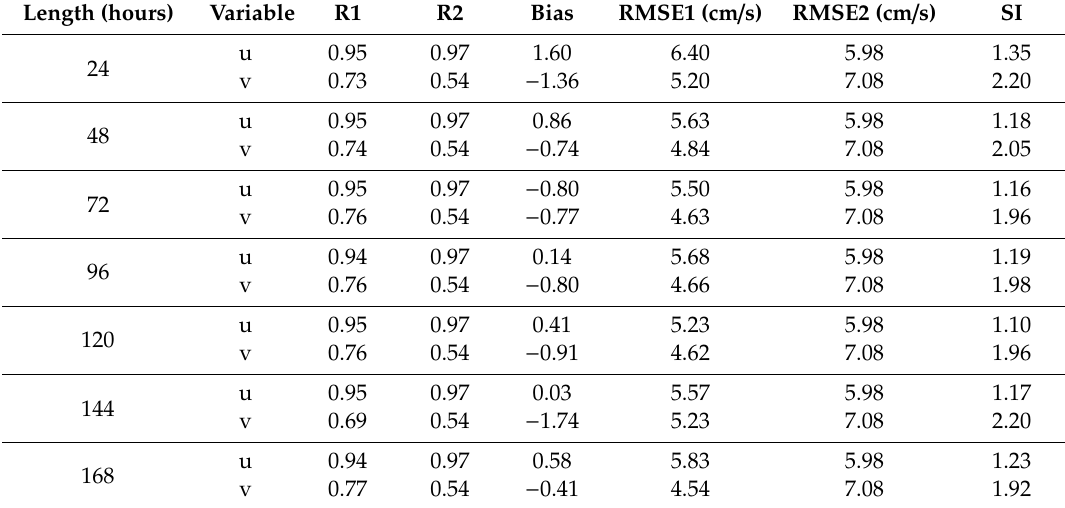
Table 7. Averaged statistics for training length tests (59-h prediction, averaged at three